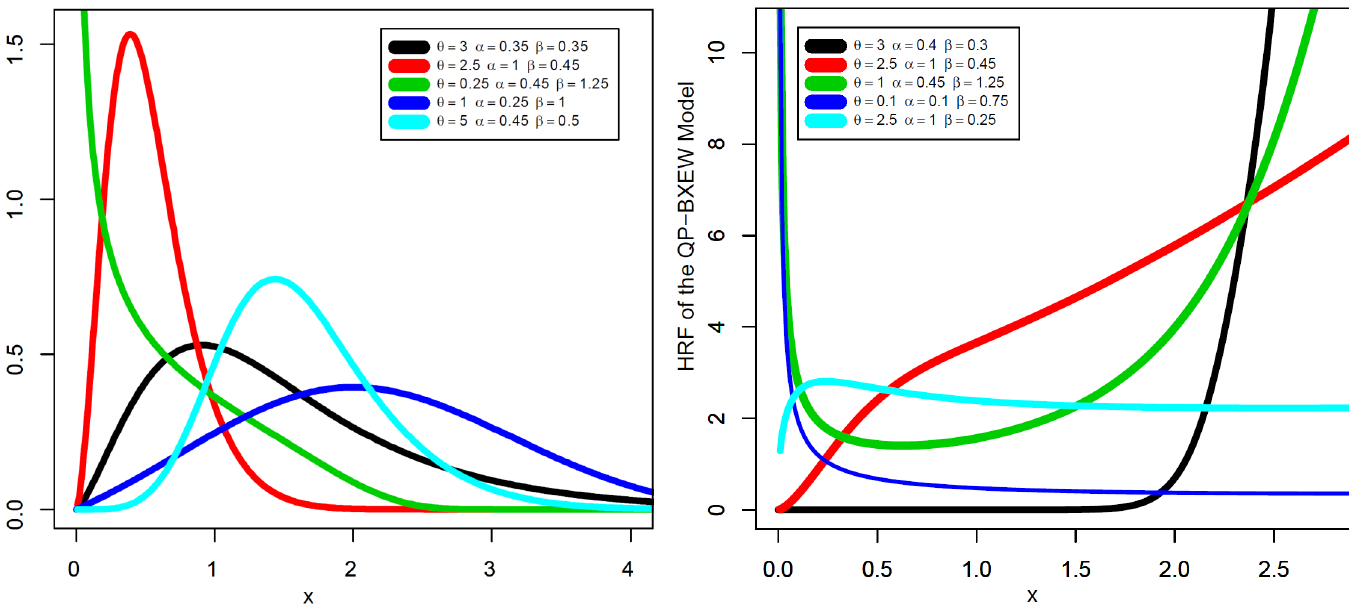
Figure 1: PDF and HRF plots for the QP-BXEW